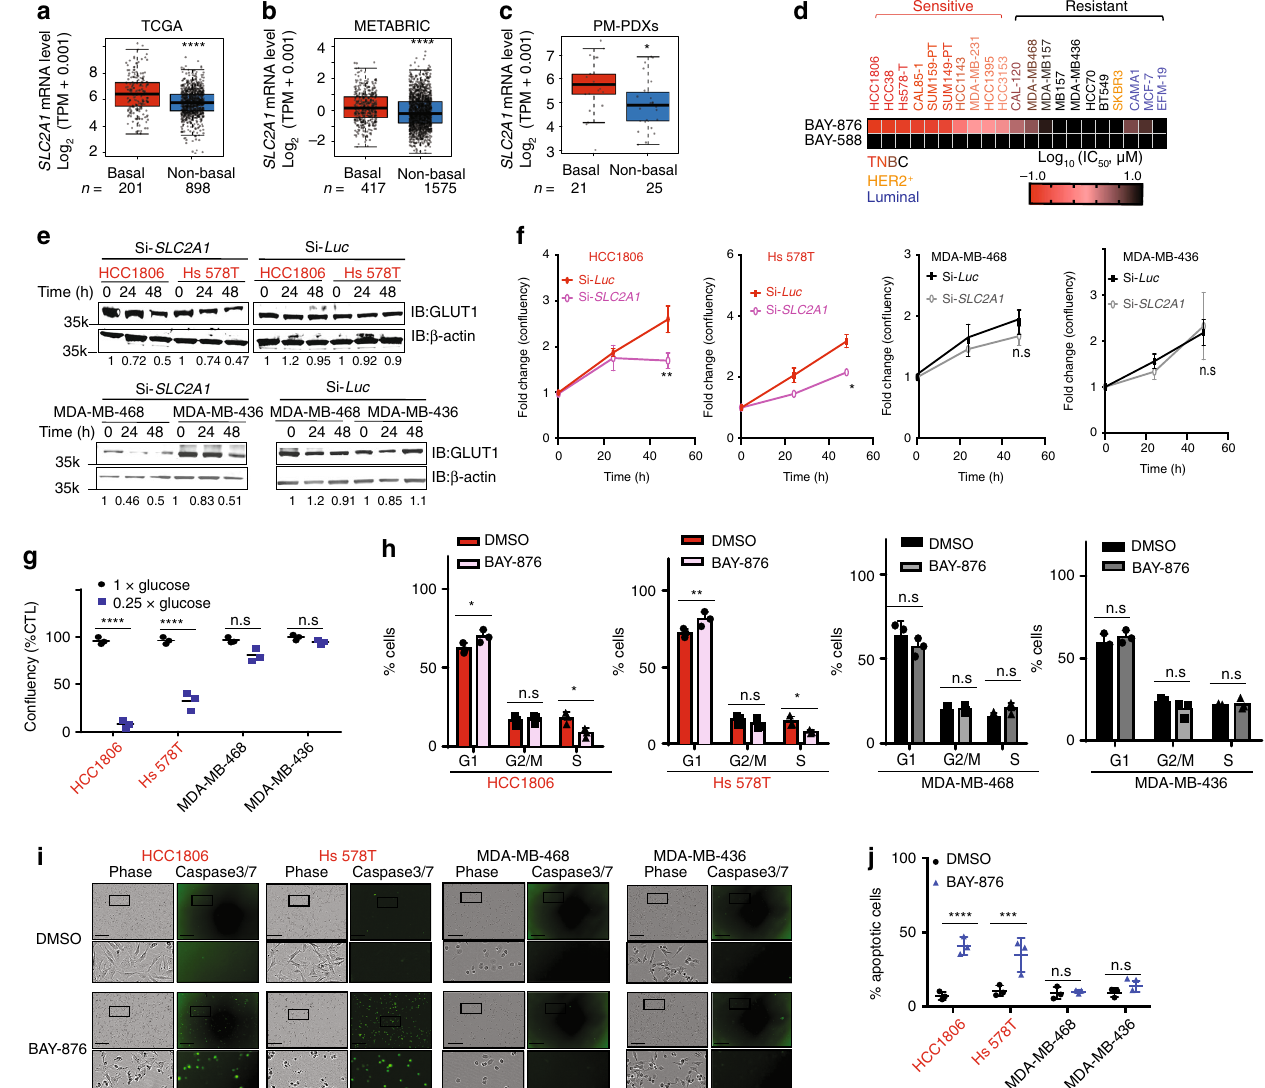
Fig. 1 Growth of a subset of TNBC relies on GLUT1 activity. SLC2A1 gene expression in the a TCGA breast cancer datasets, b METABRIC breast cancer datasets, and c Princess Margaret Hospital PDXs datasets (PM-PDXs). According to PAM50 classi fi cation, the cohorts were designated as basal and non- basal subtypes. Gene expression is reported as log 2 (TPM + 0.001). The number of patients ( n ) per group is indicated. Wilcoxon rank sum test. * p <